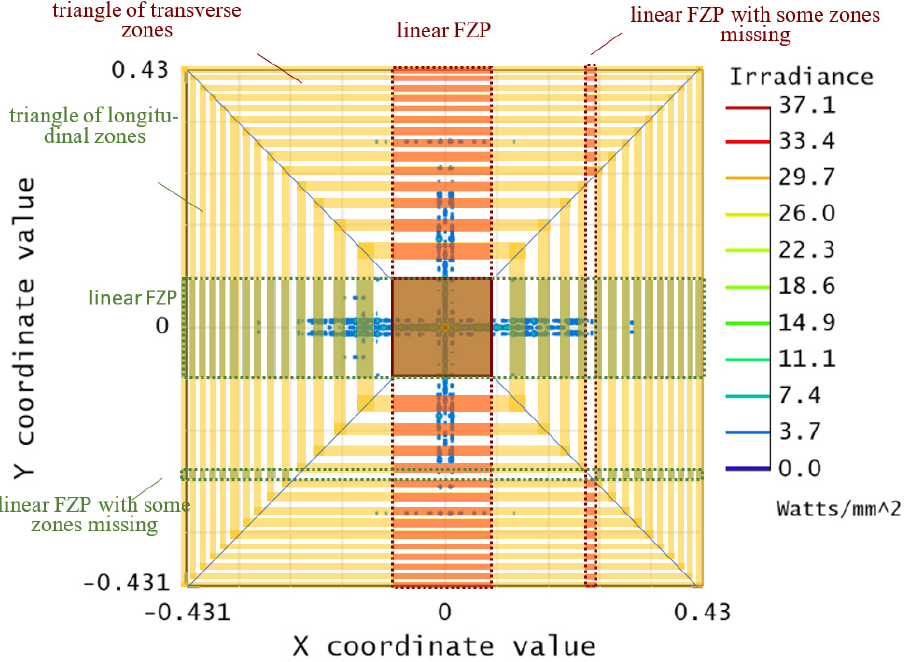
Figure 5. Structure and diffraction pattern of S-FZP.